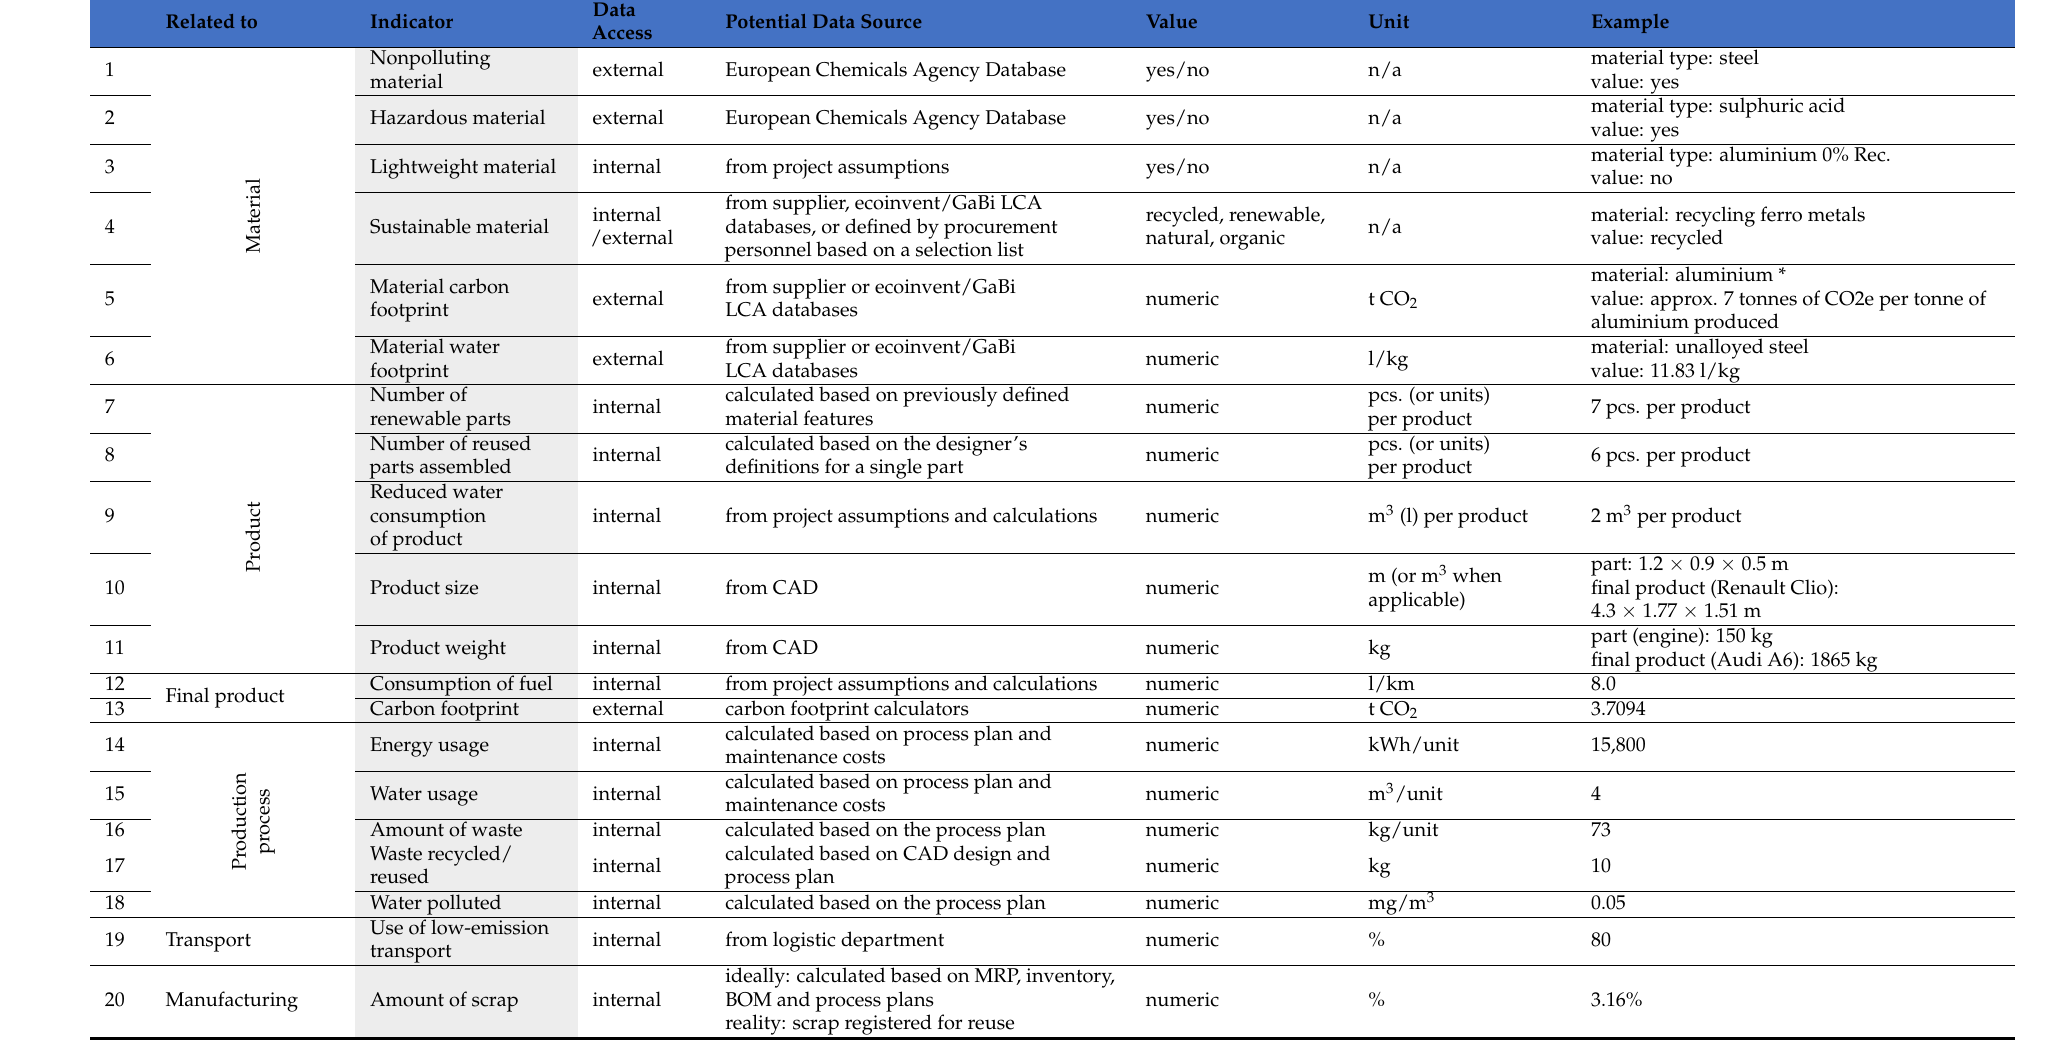
Table 6. Assignment of key green indicators to PLM stages and datasources; own